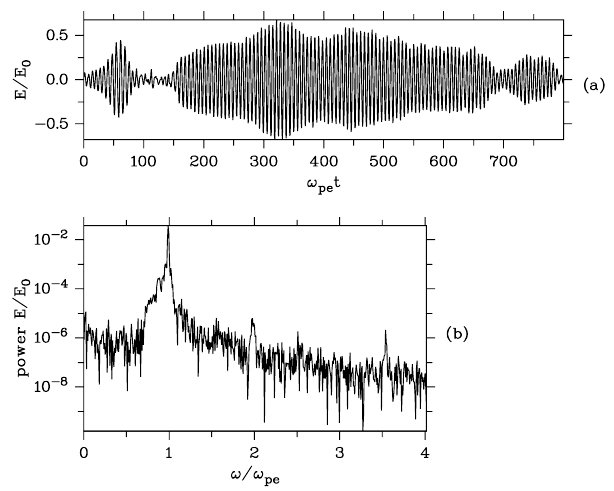
Figure 5. Time variation of the field at a fixed position x/λ D = 1200 in the box (a) and corresponding power spectrum (b) . Param- eters as in Fig.